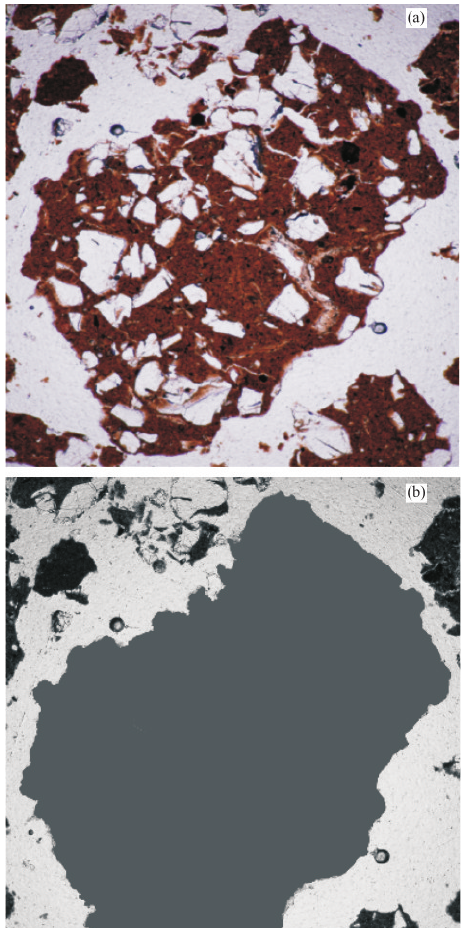
Figura 1. Microfotografia de agregado selecionado na lâmina (a) e representação da área de estudo (b). Escala: 1